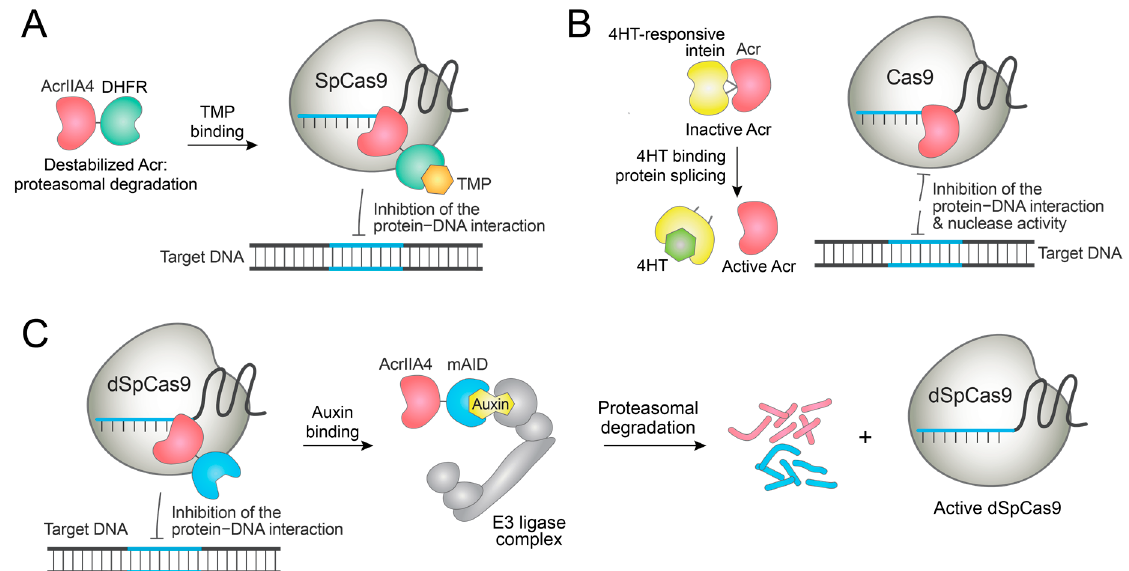
Figure 6. Examples of the small-molecule control of engineered Acr proteins. ( A ) Destabilized AcrIIA4-DHFR fusion is stabilized by TMP to switch off genome editing. ( B ) Acr proteins fused to an engineered intein are spliced by binding to 4HT, and the activated Acr proteins inhibit genome editing. ( C ) AcrIIA4 fused to mAID is degraded by auxin that acts as a molecular glue in plant cells, and dSpCas9 is activated.